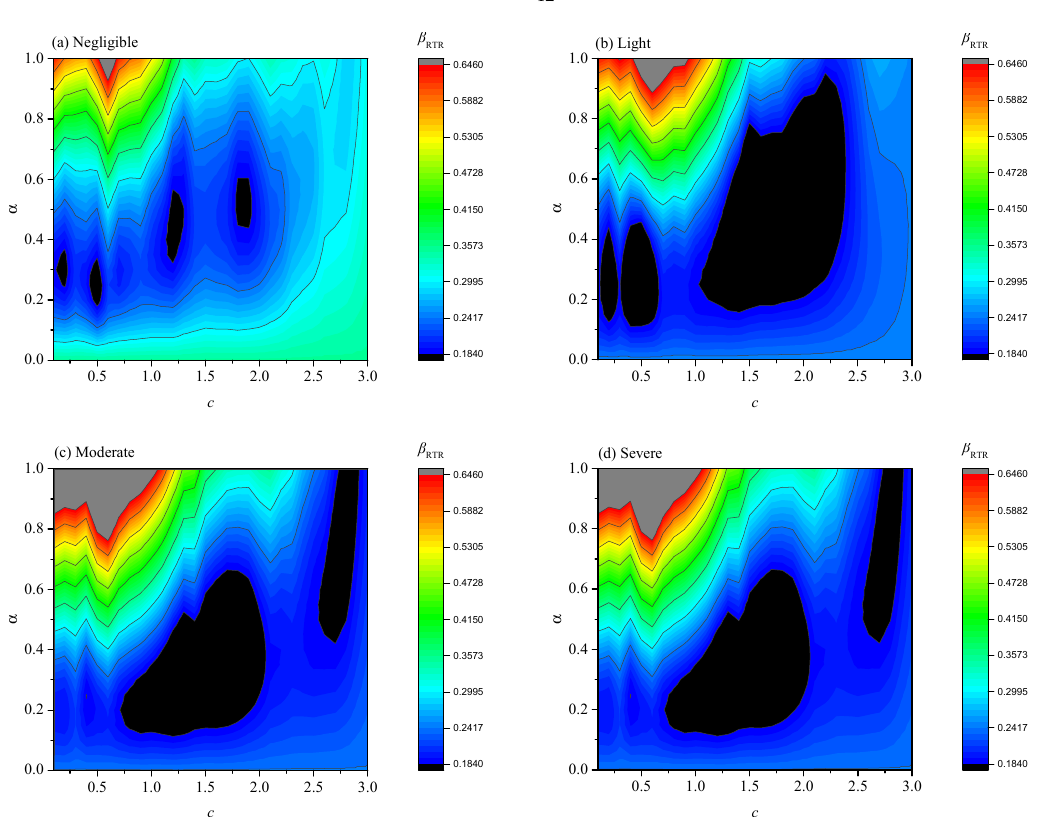
IM under far-field earthquakes. 12 under far-field earthquakes. 12